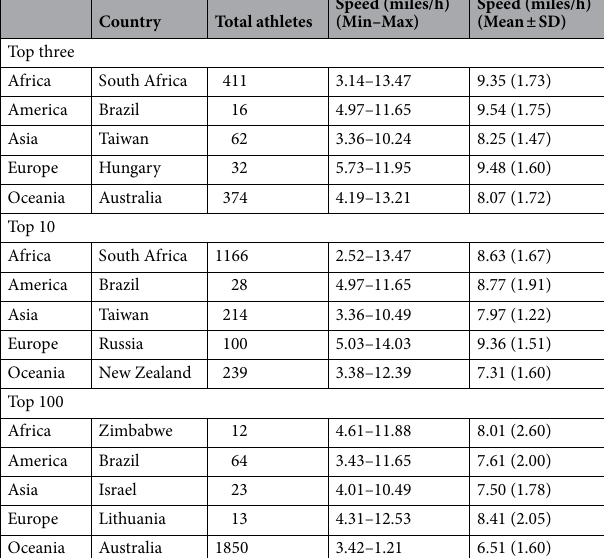
Table 3. Men descriptive results (min, mean ± SD, max) for the best country in each continent, based on a performance level. Min–Minimum value; Max–Maximum value. SD standard deviation. We only considered the best country for each continent. Countries with total athletes below 10 were not